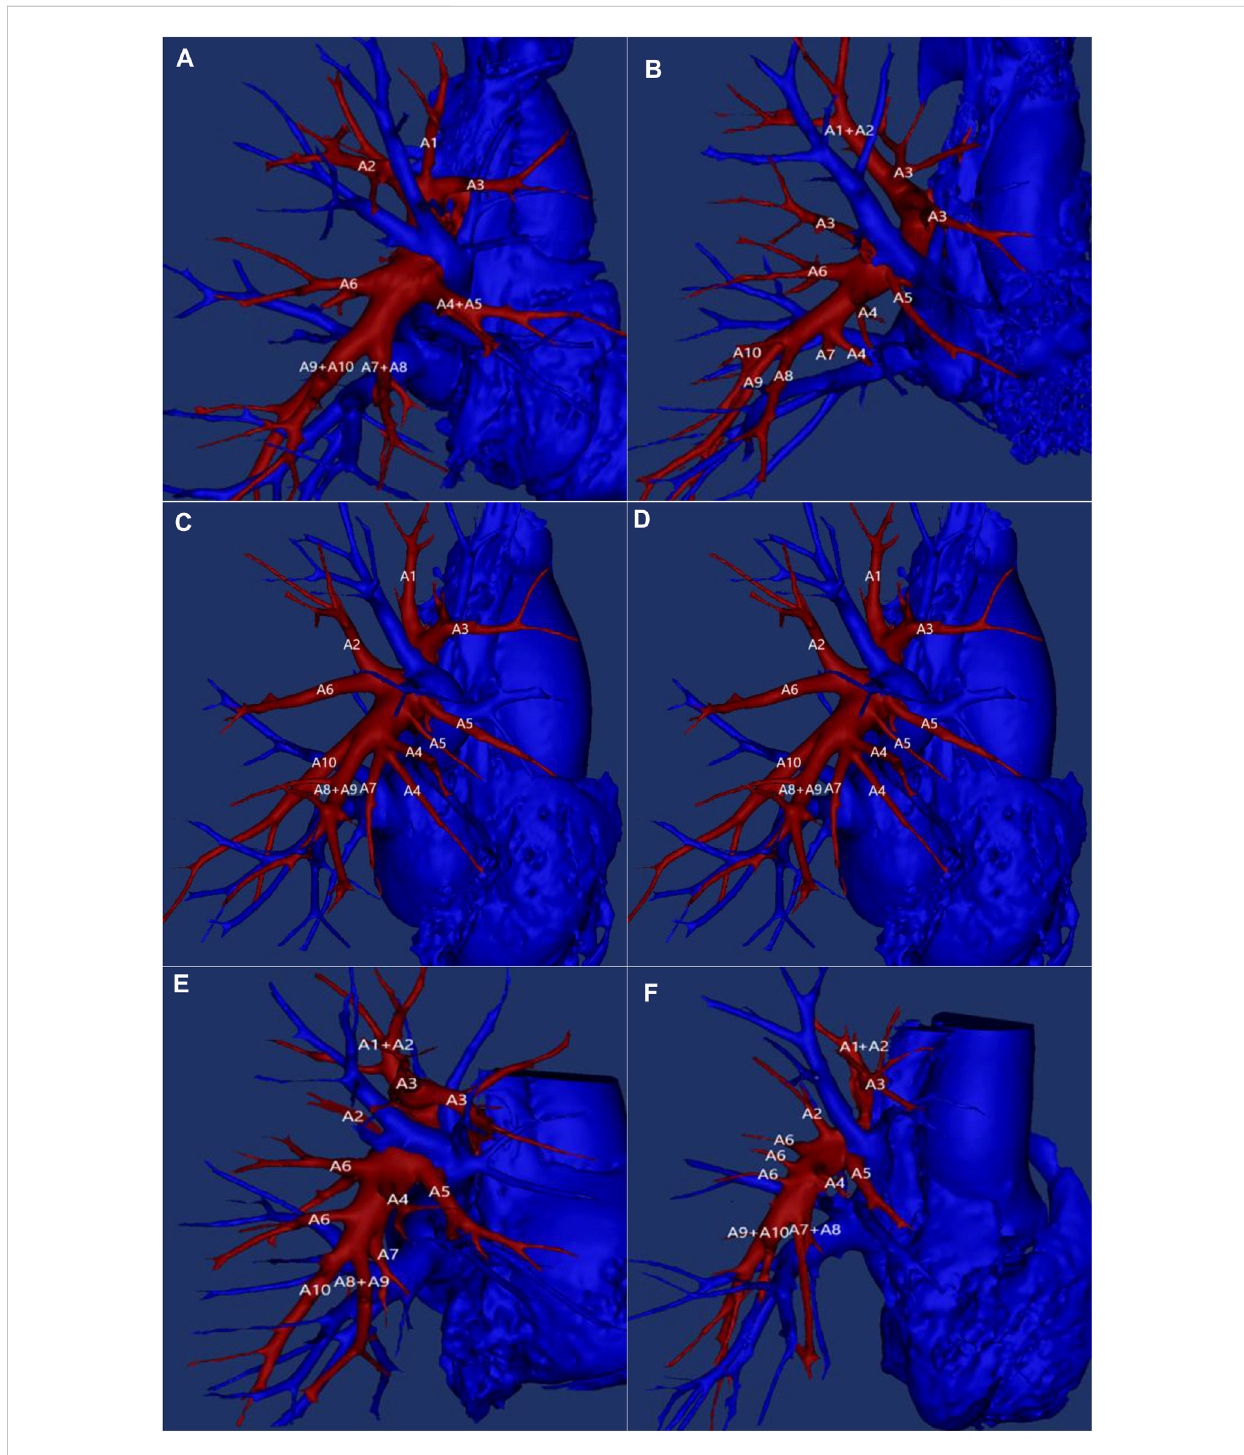
FIGURE 2 Example of right pulmonary artery vascular variation. A1: Apical segmental artery; A2: Posterior segmental artery; A3: Anterior segmental artery; A4: Lateral segmental artery of middle lobe; A5: Medial segmental artery of middle lobe; A6: Inferior lobe superior segment artery; A7: Medial basal segment artery; A8: Anterior basal segment artery; A9: lateral basal segment artery; A10: posterior basal segment